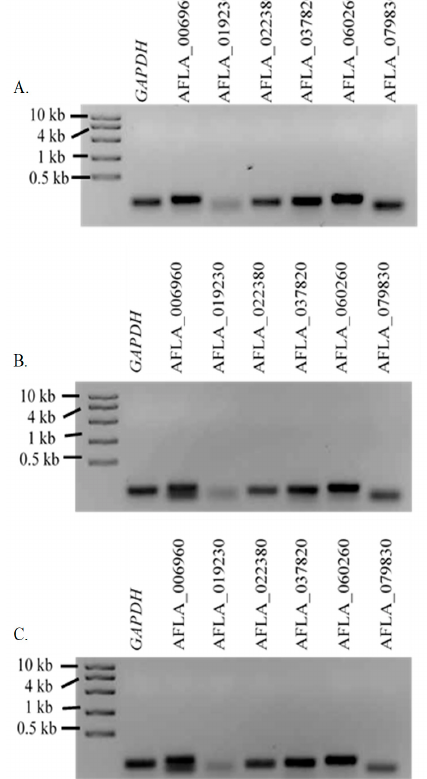
Figure 6. Transcript accumulation of selected genes by RT-PCR. GAPDH served as a control for template loading. Intensities of bands were visually compared among A. flavus strains ( A ) NRRL 3357, ( B ) NRRL 6513, and ( C ) NRRL 35739.